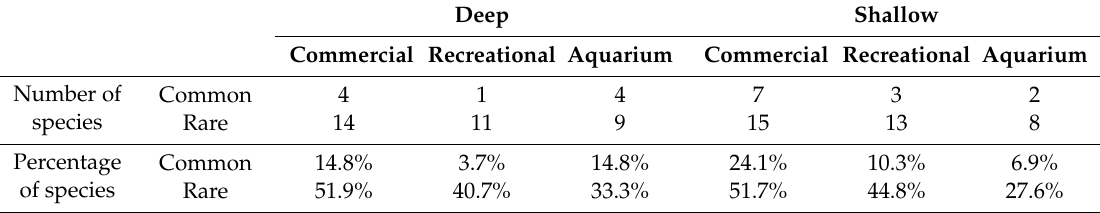
Table 2. Socioeconomically important fisheries species in deep and shallow seagrass in the Great Barrier Reef World Heritage Area. Values are numbers of species, shown as common ( > 10 individuals at that depth) and rare ( < 10 individuals at that depth) and percent of species for each depth. Species can be in the > 1 fishery